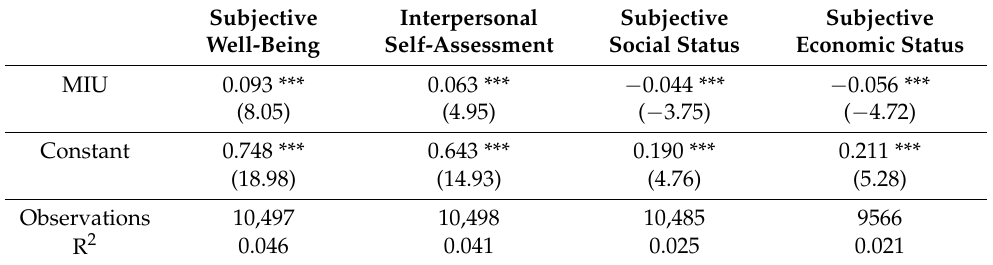
Table 14. Mediation effect 1.